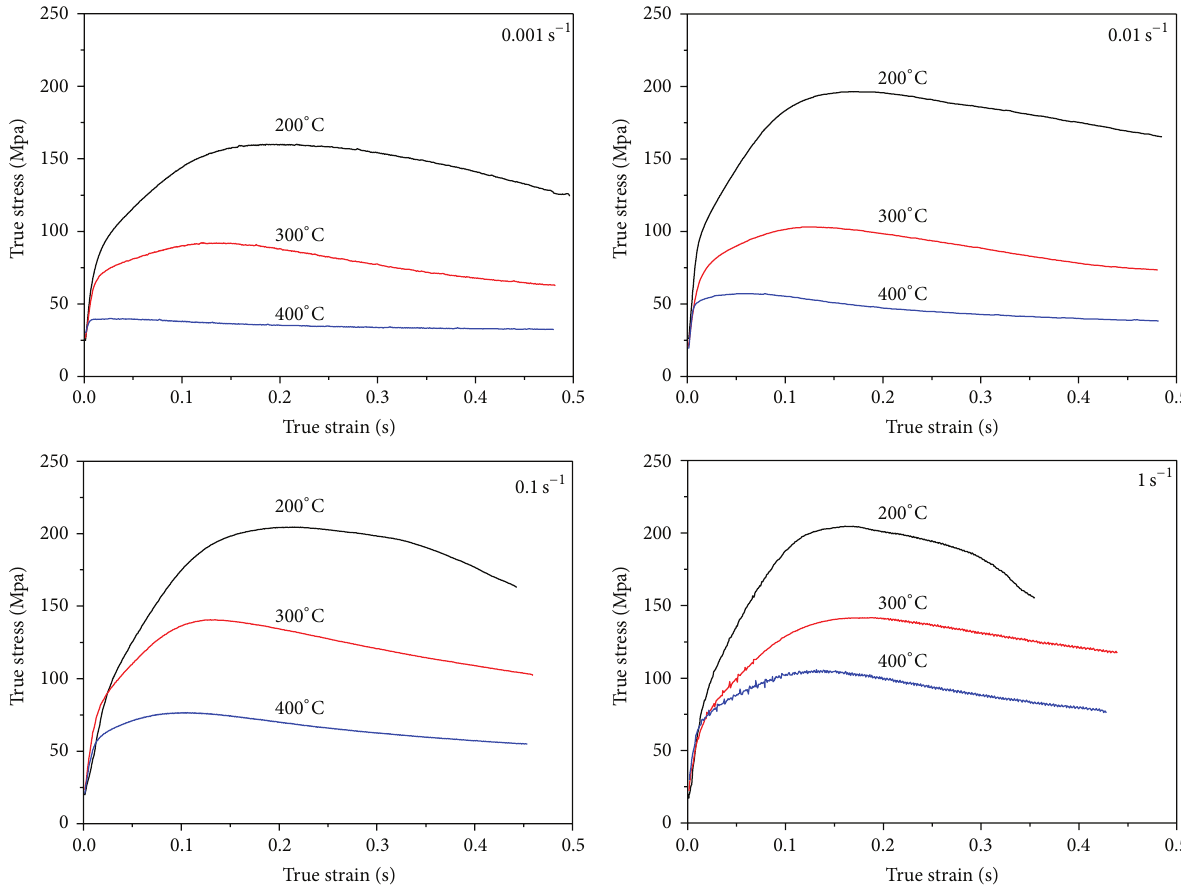
Figure 5: True stress-true strain curves of AZ81 magnesium alloy during hot compression deformation.